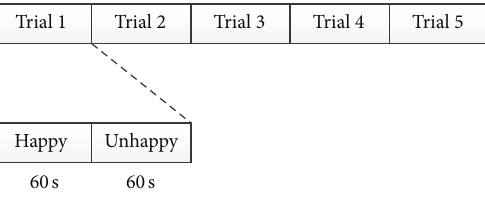
Figure 5: Procedure of